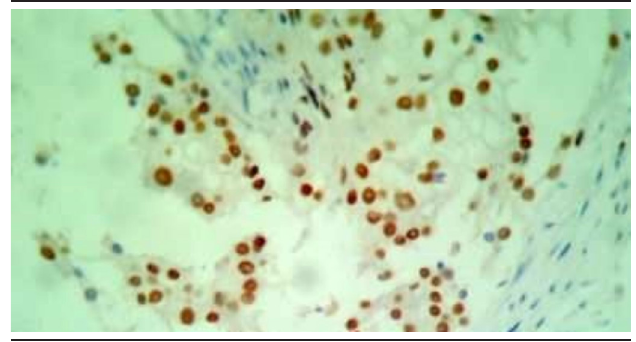
FIGURA 4 – Resultado da